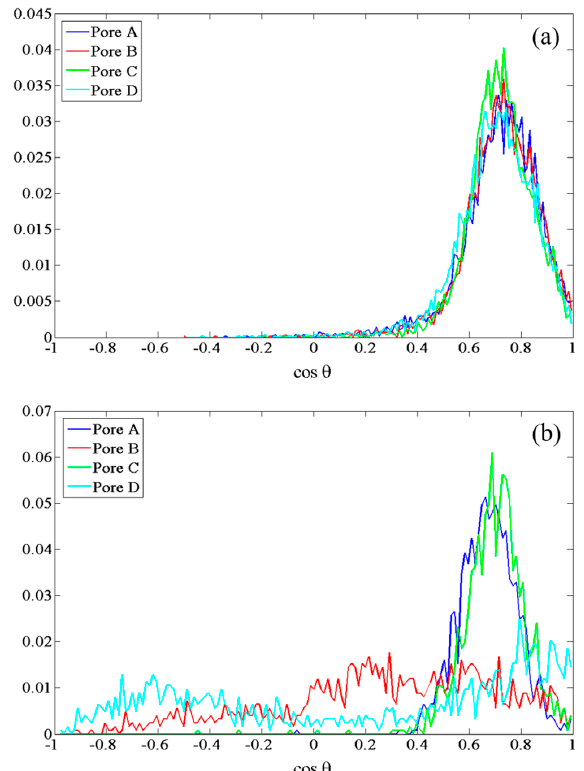
Figure 4. Normalized probability distribution of cos θ , for CYS-178 in the “lower” gate (see Figure 2): ( a ) in all four pores under zero-field conditions; and ( b ) in all four pores in a static field of 0.065 V/Å along the − y -axis.